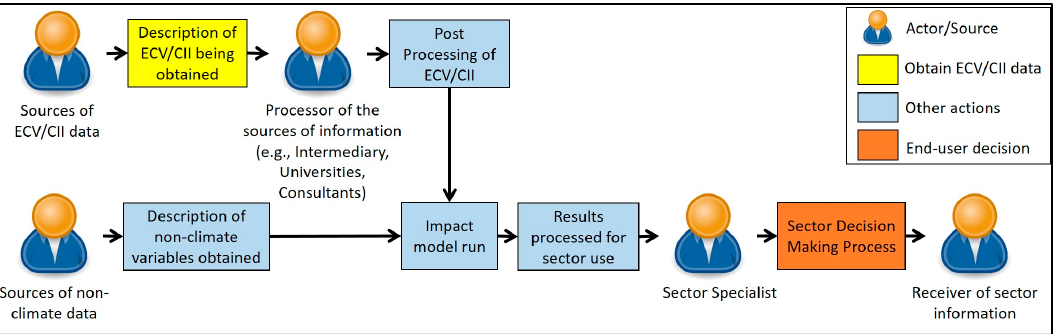
Figure 5. Basic use case diagram example. (CII = Climate Impact Indicator).